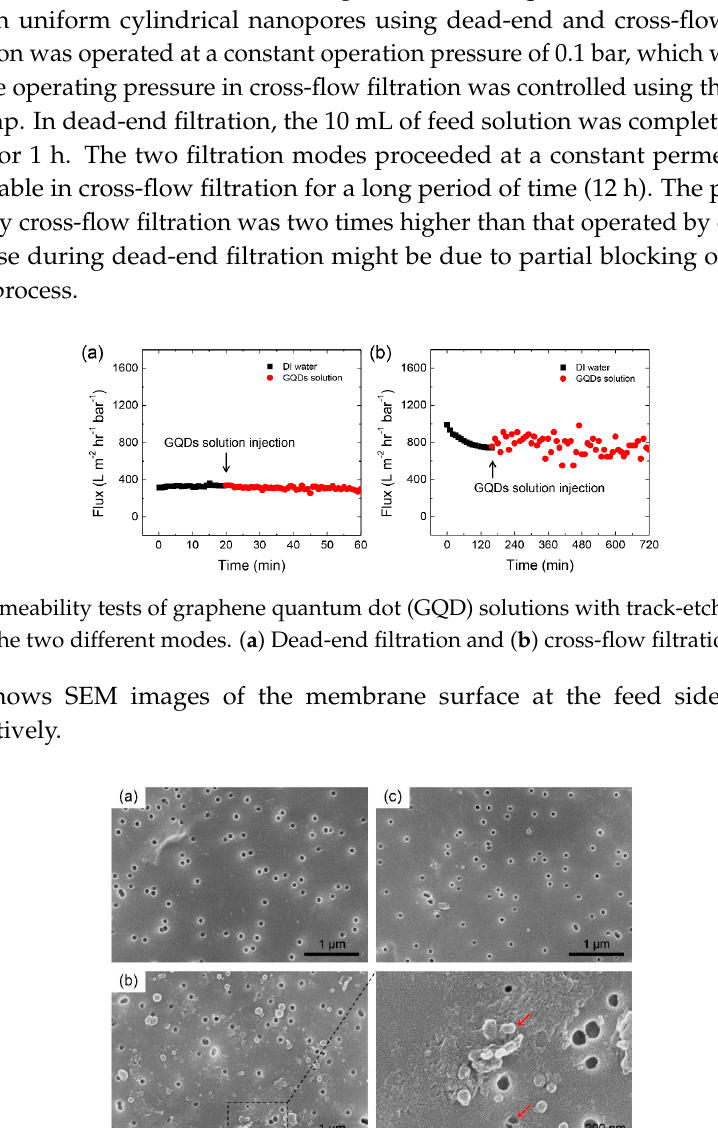
Figure 3. Scanning electron microscope (SEM) images of the top surface of track-etched membranes before and after filtration of GQD solutions in both modes. ( a ) Top surface image of the membrane before filtration. ( b ) Membrane surface at the feed side after dead-end filtration ( left ) and zoomed-in image of the blocked region highlighted by dashed lines ( right ). ( c ) Membrane surface at the feed side after cross-flow